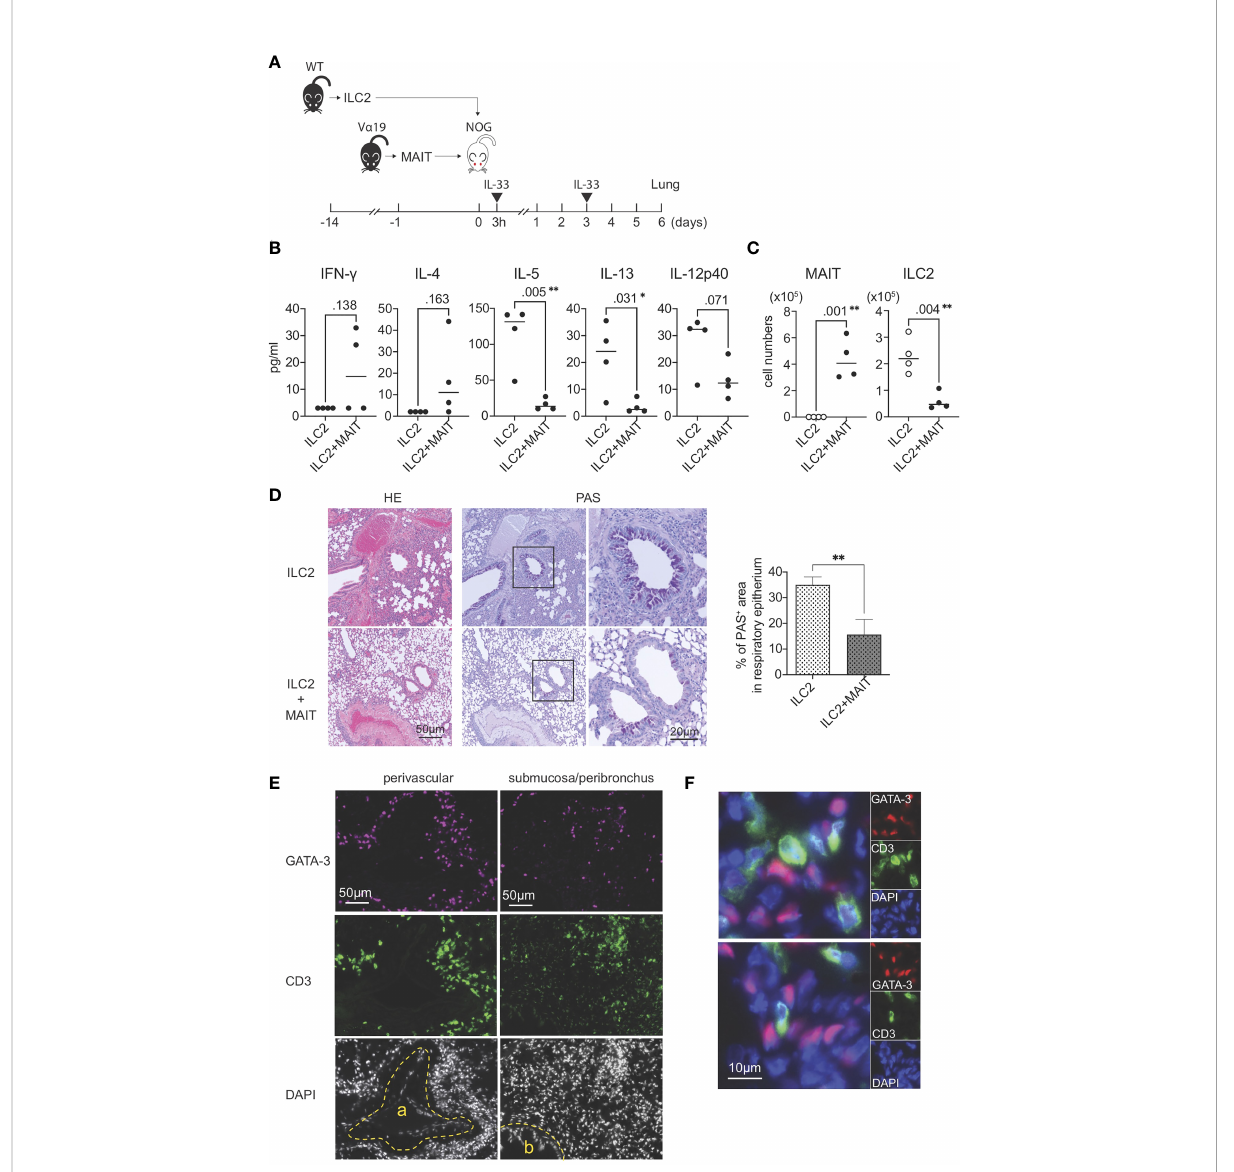
FIGURE 4 Reconstituted suppression of ILC2-mediated allergic airway in fl ammation by MAIT cells. (A) Schematic representation of the experiment. ILC2s (1.0 x 10 6 cells/mouse, the purity >89% de fi ned as CD90.2 + ST2 + cells among CD45 + lineage - cells) alone from wild-type (WT) mice or in combination with sort-puri fi ed MAIT cells (1.0 x 10 6 cells/mouse, the purity >79% de fi ned as B220 - CD19 - F4/80 - TCR b + MR1 tetramer + cells among lymphocytes) from V a 19 mice (V a 19) were adoptively transferred into NOG mice followed by an intranasal challenge with IL-33 (0.5 m g in 20 m l PBS per mouse) as indicated. Sampling was performed on day 6. (B) Cytokines in BALF. The concentrations of the indicated cytokines in BALF from NOG mice received only ILC2s (ILC2) or both ILC2s and MAIT cells (ILC2+MAIT) are shown. Data are shown as mean ± SD (n=4), *P <0.05, **P <0.01. (C) Suppression of ILC2 accumulation in the lungs. The numbers of MAIT cells and ILC2s in the lungs of NOG mice received ILC2s only, and those received both ILC2s and MAIT cells are shown. MAIT (MAIT cells), ILC2 (ILC2s) Data show mean ± SD (n=4), **P <0.01. (D) MAIT cell-mediated mitigation of lung in fl ammation. HE and PAS staining of lung tissue sections from NOG mice received only ILC2s (ILC2, upper panels) and those received both ILC2s and MAIT cells (ILC2+MAIT, lower panels) are shown. Bars indicate 50 m m and 20 m m, respectively. In PAS staining, the rectangles indicate the enlarged regions shown on the right. Right panel shows the percentage of PAS + area within the epithelial cells. **P <0.01. Representative data from at least 5 different areas are shown (n=3). (E) Localization of ILC2s and MAIT cells in the lungs. ILC2s and MAIT cells in the NOG mouse lungs upon adoptive transfer are identi fi ed with surrogate markers. ILC2s are shown as GATA3 + cells (red or magenta) and MAIT cells as CD3 + cells (green) within tissue sections representing the perivascular, submucosal, and peribronchial regions. a: artery, b: bronchus. Nuclei are stained with DAPI. Bars indicate 50 m m. Representative data from 4 mice are shown. (F) Juxtaposition of ILC2s and MAIT cells in the lungs. Representative superimposed images of GATA3-expressing cells (magenta) and those expressing CD3 (green), representing ILC2s and MAIT cells, respectively, in the NOG mouse lungs. Nuclei are stained with DAPI (blue). Bars indicate 10 m m. Representative data from 4 mice are